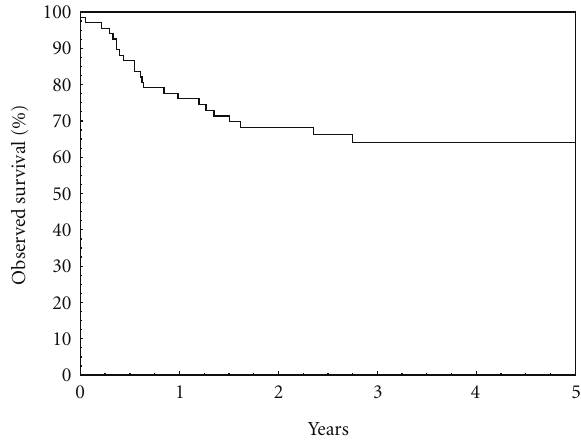
Figure 1: Observed survival, all patients. OS = 64,1 (95% CI 55,0– 73,2) at 5 years.